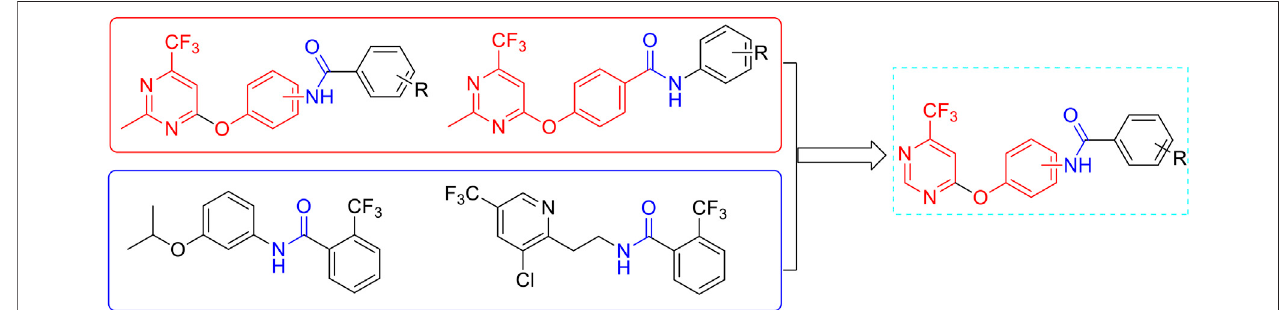
FIGURE 1 | Design of the target